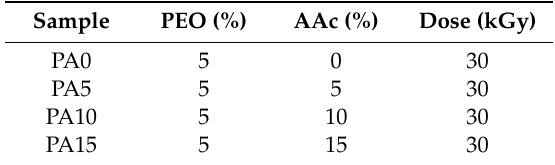
Table 1. Feed composition and optimized radiation dose for the prepared hydrogels. Sample